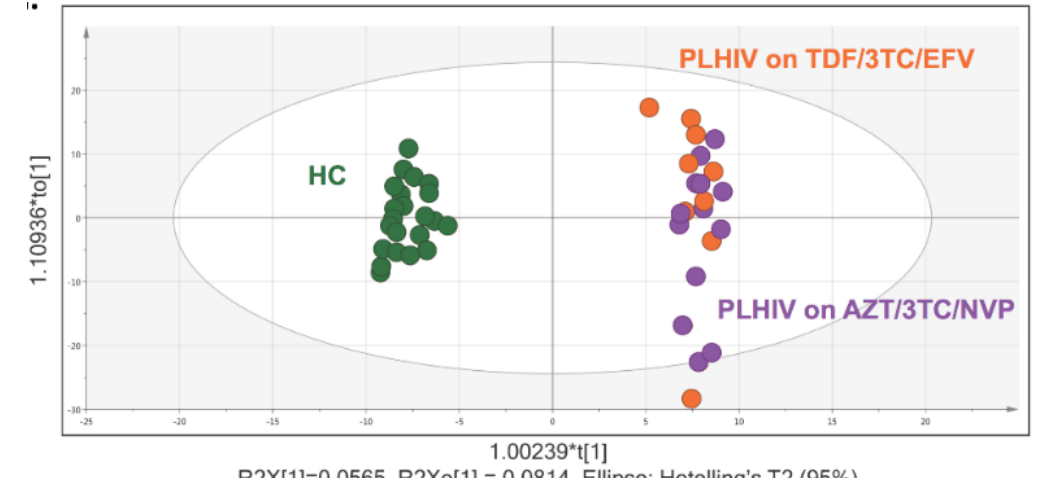
Figure 1. Orthogonal partial least square discriminant analysis (OPLS-DA) and metabolite summary: (a) OPLS plot using 1114 biochemicals, of which 901 compounds were of known identity (named biochemicals) and 213 compounds of unknown structural identity (unnamed compounds) identified group clustering of human immunodeficiency virus (HIV)-negative control (green) and people living with HIV (PLHIV) on Tenofovir/Lamivudine/Efavirenz (TDF/3TC/EFV) (orange) and PLHIV on Zidovudine/Lamivudine/Nevirapine (AZT/3TC/NVP) (purple).